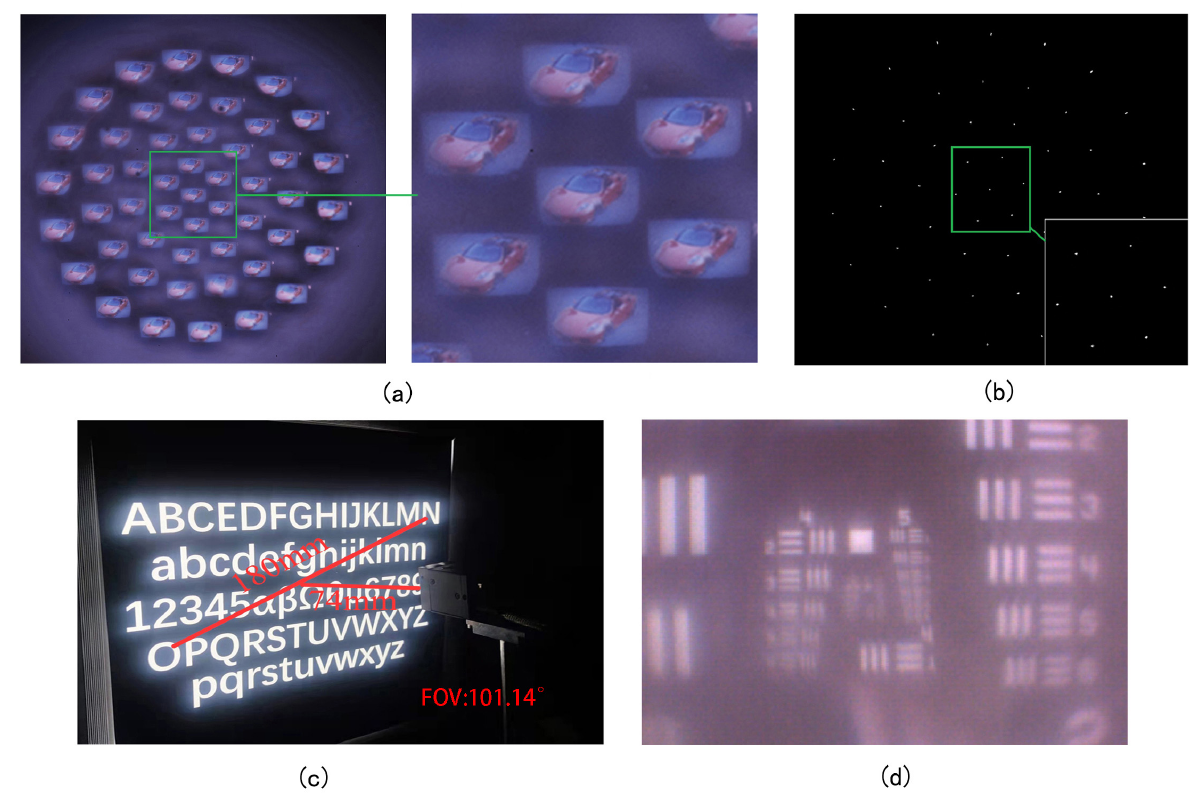
Figure 7. ( a ) Shoot results. ( b ) The focal spot of each ring. ( c ) Field angle measurement of compound eye camera. ( d ) Compound eye resolution test.